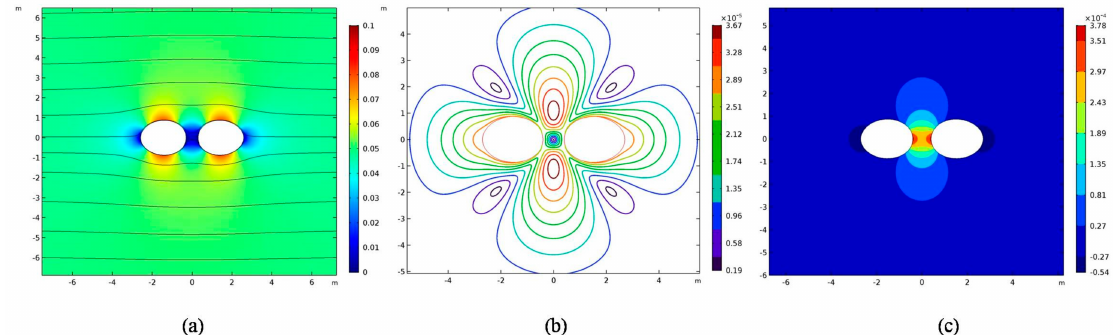
Figure 3. Distributions of the electric field ( a ), fluid field ( b ), and pressure ( c ) around two particles located at ( x ∗ , y ∗ ) = ( ± 1.56,0 ) subjected to an external electric field E ∗ = 0.05. Lines in ( a – c ) represent, respectively, the streamlines of the electric field, flow field, and